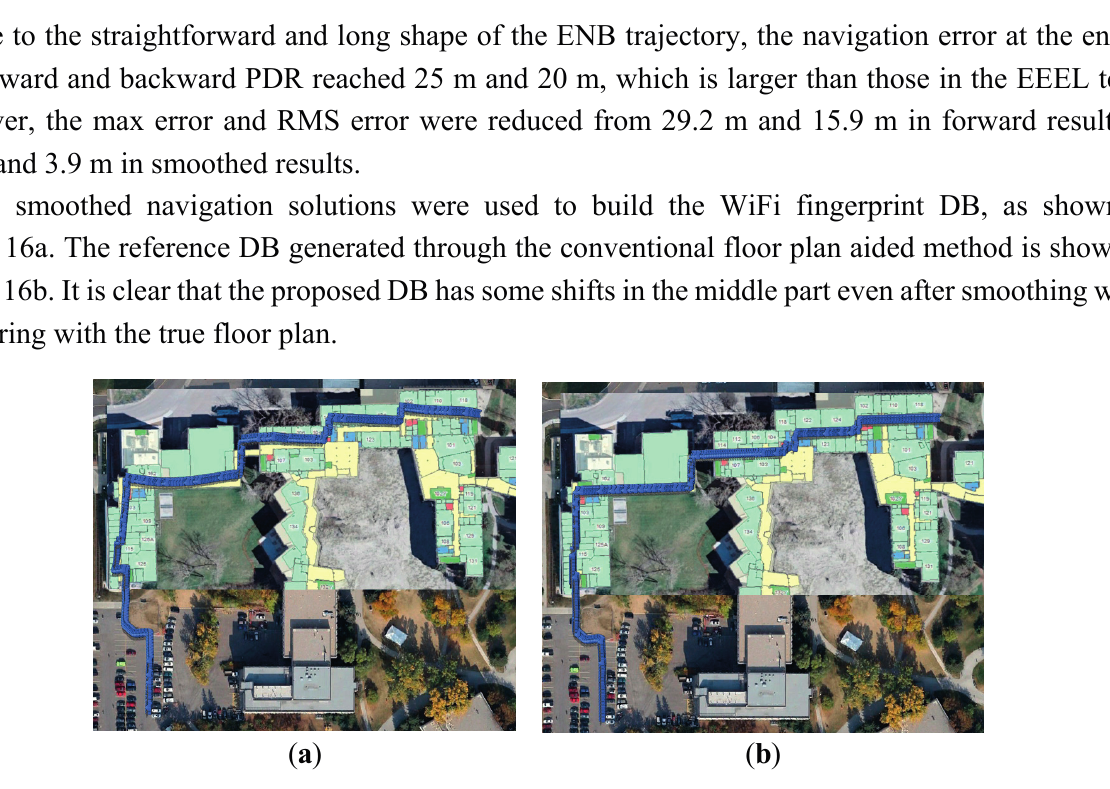
Figure 16. The DB built through proposed method ( a ), and the reference DB built by using the conventional floor plan aided training approach ( b